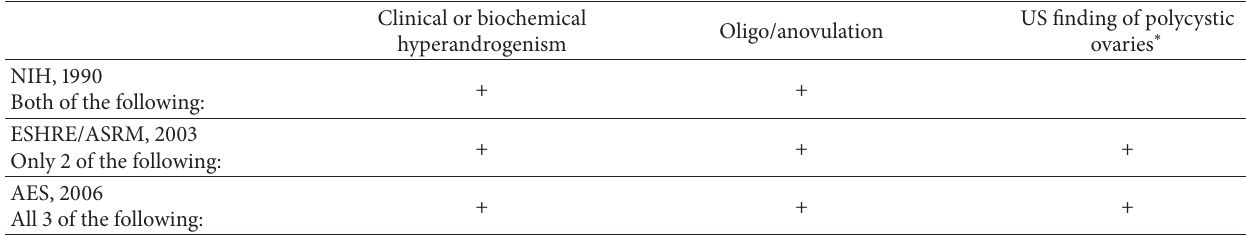
Table 2: Diagnostic criteria for polycystic ovary